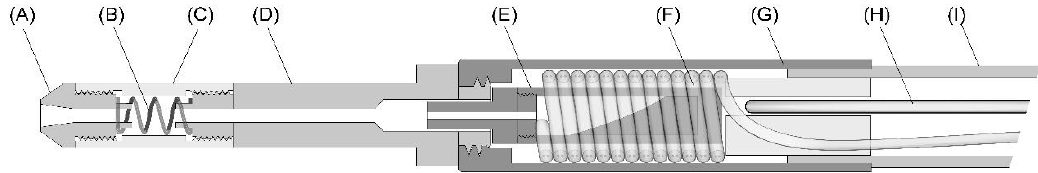
Figure 5. Cross section of the oven rod with built-in electron source. ( A ) Tungsten nozzle tip cap assembly. ( B ) Spiral tungsten filament: 1% Th-W wire with a diameter of 0.8 mm. ( C ) Electron attachment cell: cylindrical ceramic insulator with a length of 19 mm and inner diameter of 5 mm. ( D ) Tungsten nozzle base assembly. ( E ) Carbon crucible. ( F ) Micro-heater: spiral-shaped metal sheathed heater with an outer diameter of 1.6 mm. ( G ) Cu-W alloy cylindrical shell. ( H ) Sheathed thermocouple. (I) Half-inch diameter stainless-steel pipe.